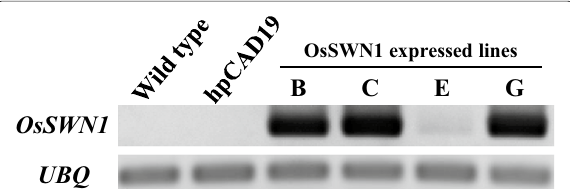
Fig. 2 Detection of transcripts from chimeric OsSWN1 by reverse transcription and subsequent polymerase chain reaction (RT-PCR). A primer pair that can amplify a part of the OsSWN1 -coding region was used in this analysis. Transcripts from the ubiquitin gene were also analyzed as a control. Nucleotide sequences of the primers are indicated in Additional file 1: Table